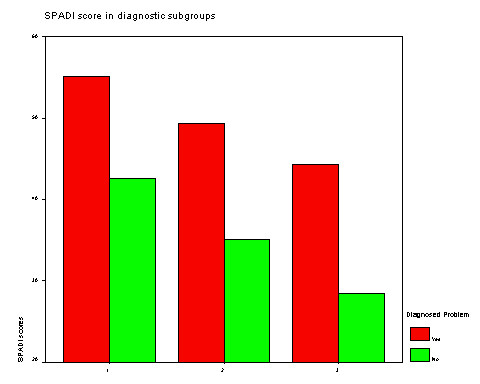
SPADI scores over time according to diagnostic subgroups. This graph shows the SPADI score in patients that had a specific diagnosis for their shoulder pain and those who did not. Significant improvements occurred across time in both groups. Patients with a specific diagnosis had higher pain and disability at all 3 time-points (p < 0.001).